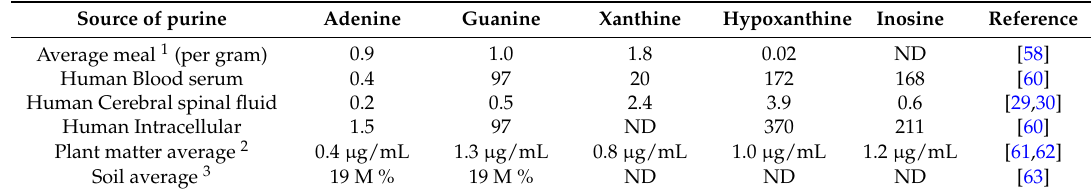
Table 1. Concentration of purines ( µ M unless indicated) from the habitats of C. albicans , A. fumigatus and C. neoformans . Adenine Average meal 1 (per